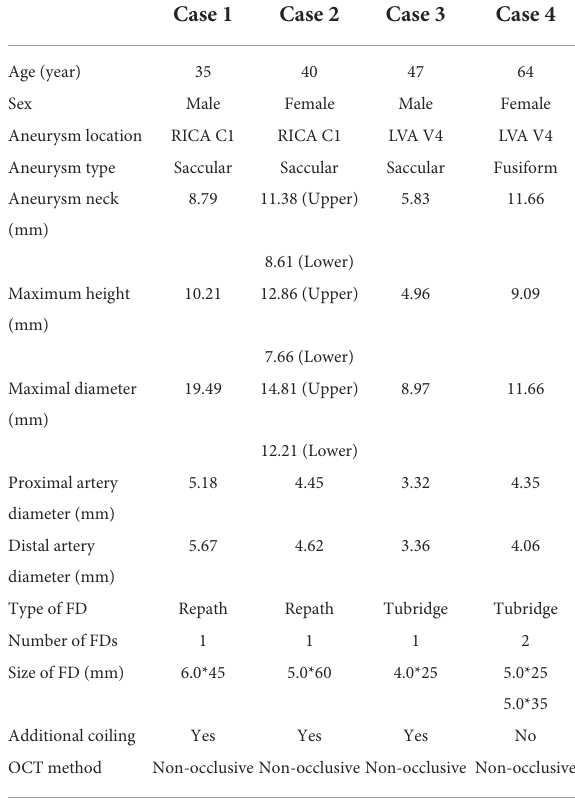
TABLE 1 Clinical details of the